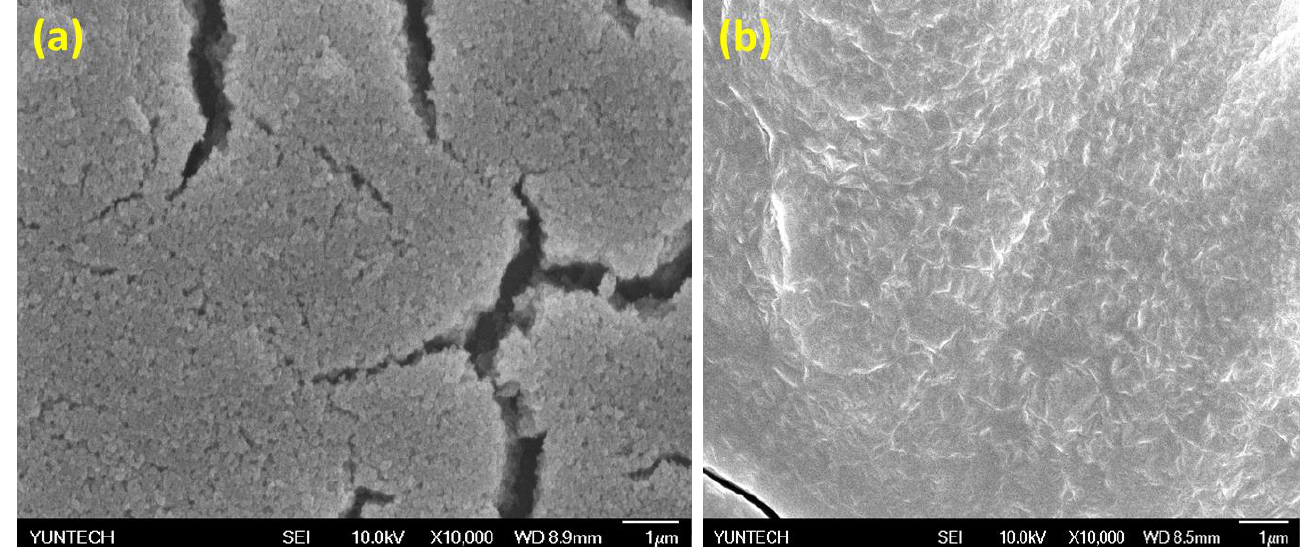
Figure 4. The SEM images of (a) MOF-808 and ( b ) C-MOF-808.